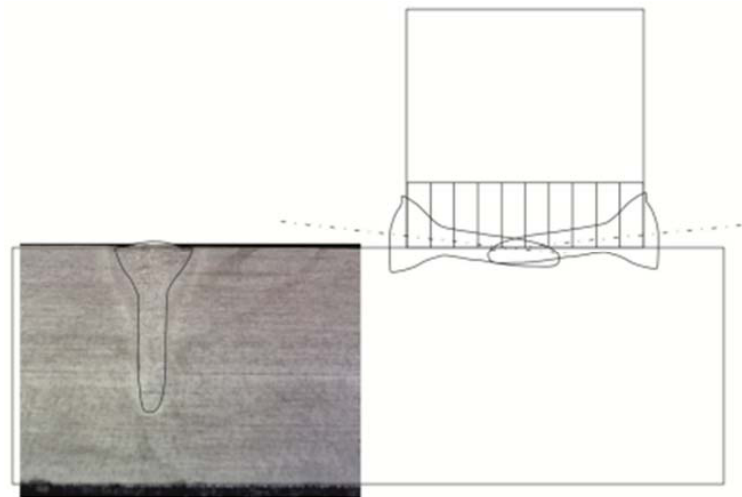
Figure 2. Macrostructure of the plate penetration run performed using a laser beam power of 7 kW, the outlined fusion line, and the outline of the penetration run plotted on the schematic diagram of the T-joint.